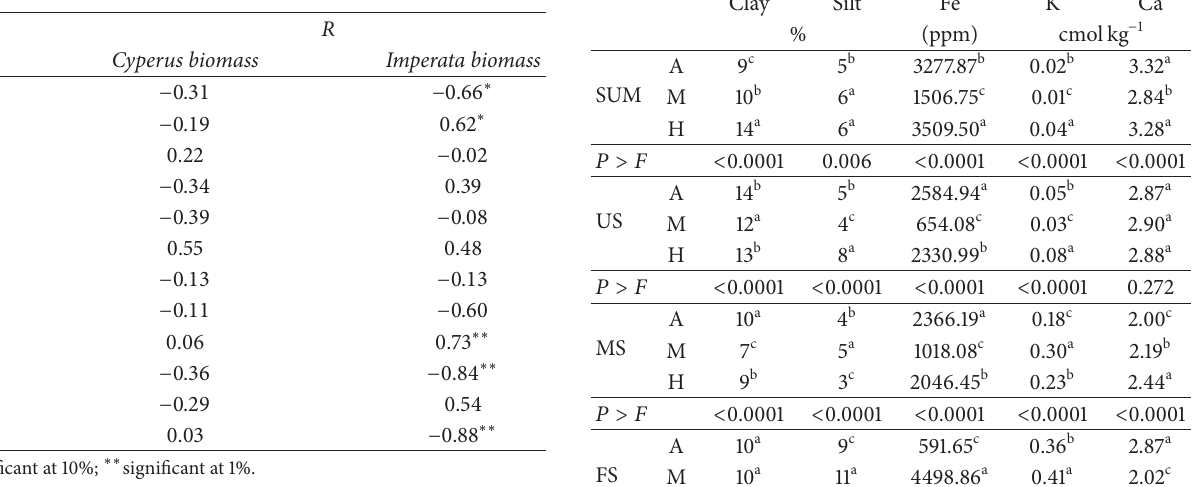
Table 2: Pearson correlation coefficient values between soil charac- teristics and the dry matter of Cyperus and Imperata in their respec- tive high density quadrate placement.